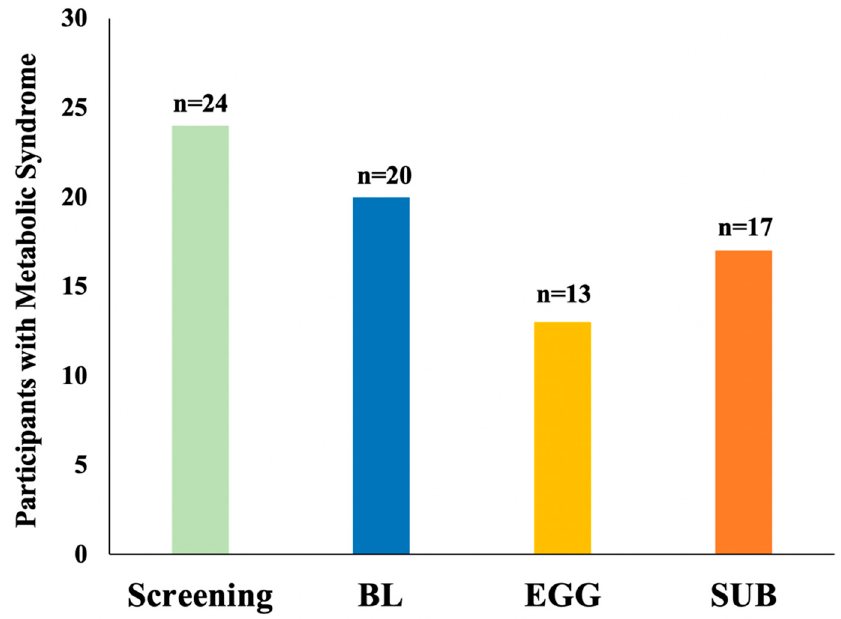
Figure 5. Participants classified with MetS at screening, at baseline (BL), and following the EGG and SUB periods.